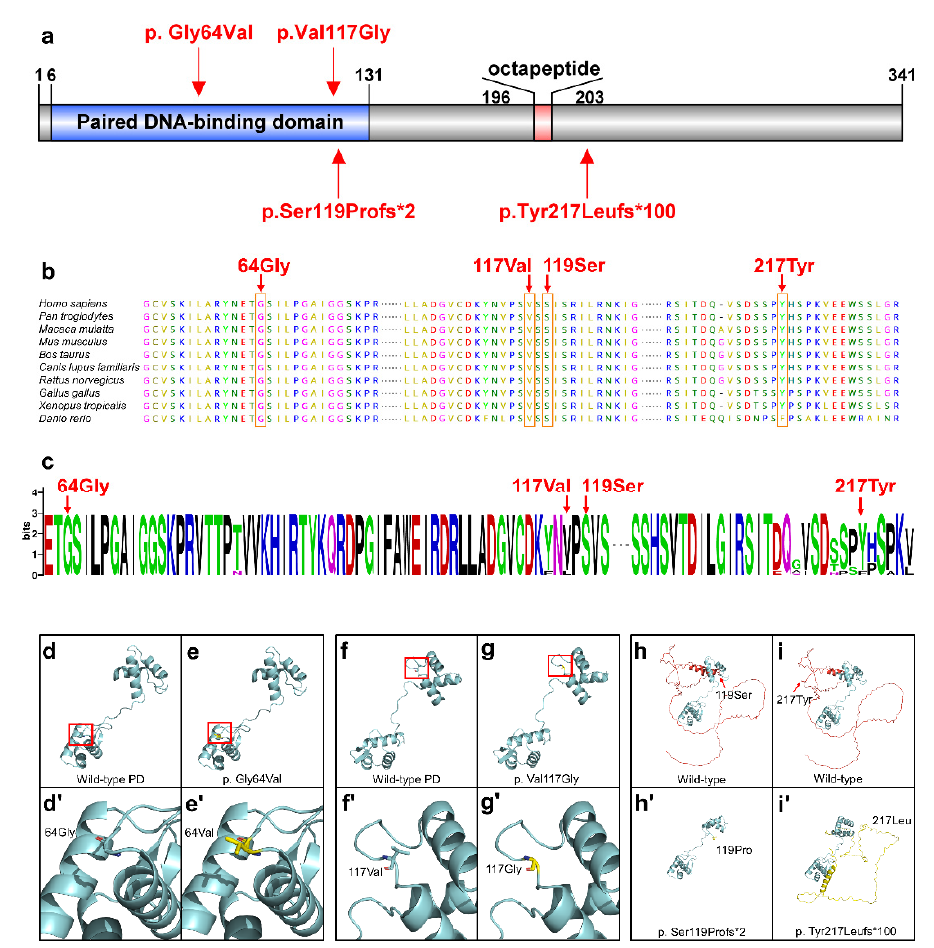
Figure 2. Conservation and bioinformatics analysis of the PAX9 variants. ( a ) Schematic diagram of the wild-type PAX9 protein and the localization of the 4 novel PAX9 variants identified in this study. ( b ) Conservation analysis of the PAX9 amino acid sequences among different species. ( c ) Weblogo analysis of the PAX9 amino acid sequences among different species. ( d ) 64Gly in wild-type PD. ( d’ ) Higher magnifications of the above boxed regions surrounding the 64Gly. ( e ) Structural changes in p.Gly64Val in PD. ( e’ ) Higher magnifications of the above boxed regions surrounding the 64Val. ( f ) 117Val in wild-type PD. ( f ’) Higher magnifications of the above boxed regions surrounding the 117Val. ( g ) Structural changes in p.Val117Gly in PD. ( g’ ) Higher magnifications of the above boxed regions surrounding the 117Gly. ( h ) Structure of wild-type PAX9 (the amino acids behind 119Ser are shown in red). ( h’ ) Structure of p.Ser119Profs*2 in PAX9 (the changed amino acids are shown in yellow). ( i ) Structure of wild-type PAX9 (the amino acids behind 217Tyr are shown in red). ( i’ ) Structure of p.Tyr217Leufs*100 in PAX9 (the changed amino acids are shown in yellow).